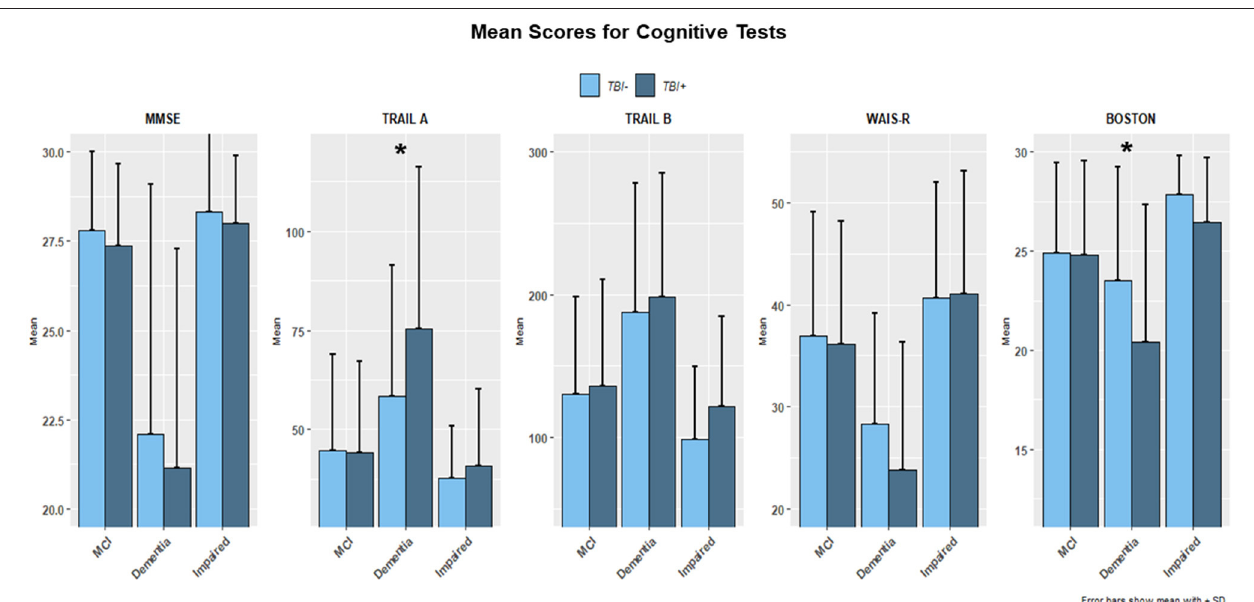
FIGURE 1 | The figure shows bar plots of the mean scores for the Mini Mental Status Examination (MMSE), Trail Making Test part A and B (TMT-A, TMT-B), WAIS-R scale and Boston Naming Test for both TBI + (subjects with a previous history of TBI at the time of their first cognitive decline assessment) and TBI– (subjects without a previous history of TBI at the time of their first cognitive decline assessment) as clustered by their associated clinical diagnosis at the time of their first cognitive decline assessment. MCI, Mild cognitive impairment, Dementia [including Alzheimer’s disease (AD), Dementia with Lewy bodies (DLB), Progressive supranuclear palsy (PSP), Corticobasal degeneration (CBD), Frontotemporal Dementia (FTD), Vascular dementia (VaD), Traumatic brain Injury (TBI), normal pressure hydrocephalus (NPH), Depression, Cognitive decline due to systematic disease or medical illness], non-AD Impairment (Impaired). For TMT-A ( p = 0.013) and Boston Naming test ( p = 0.008) a significance was found TBI + vs. TBI– groups. *indicates the presence of statistical significance ( p -values <